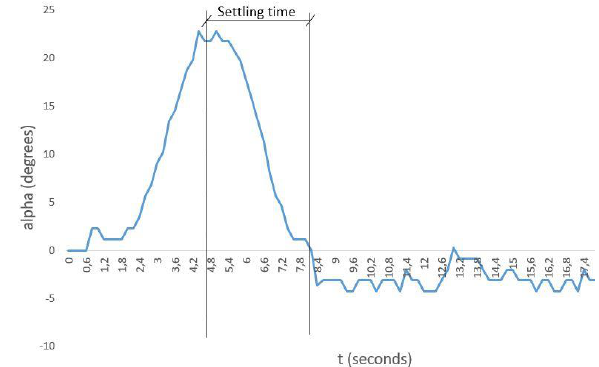
Figure 10. Angular control system